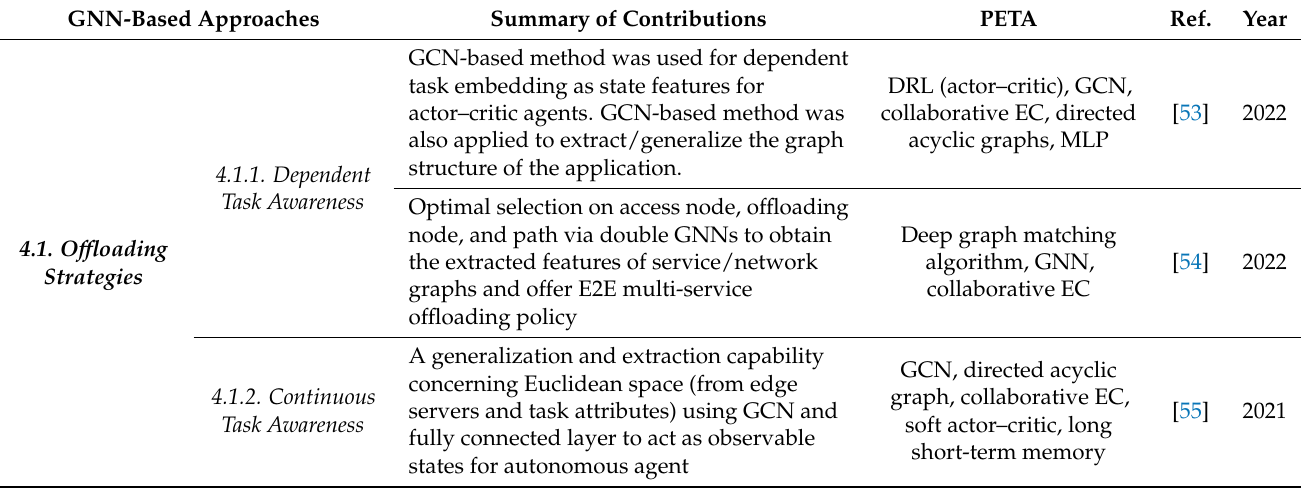
Table 3. Summary of Selected Works in GNN-Based Offloading Strategies. GNN-Based